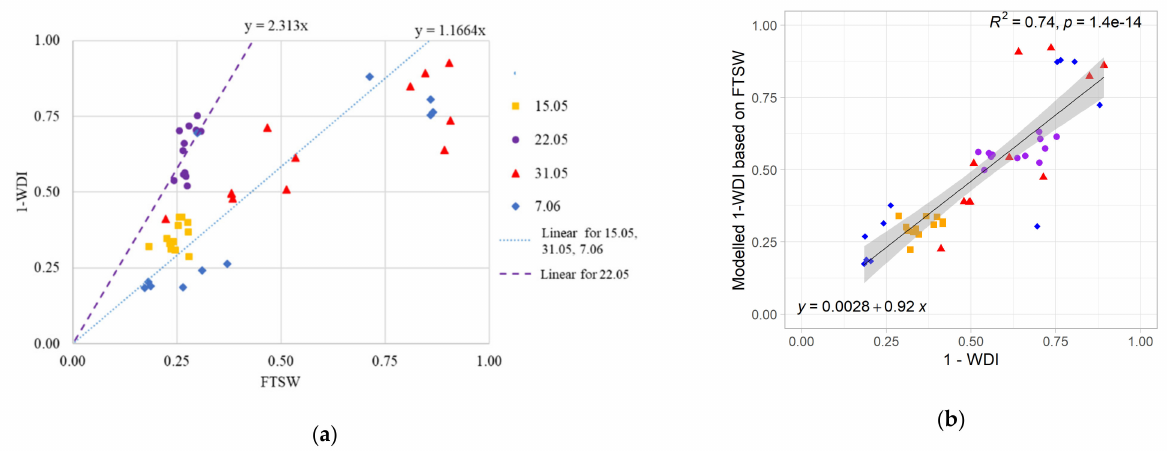
Figure 4. ( a ) Relationship between the Transpirable Soil Water Fraction ( FTSW ) and transpiration rate (1- WDI ; WDI is the Water Deficit Index from images acquired during solar noon) for the winter wheat season in 2018 in Denmark. ET p = 0.49–0.54 mm h − 1 on 15 and 31 May and 7 June and ET p = 0.39 mm h − 1 on 22 May; ( b ) fit between transpiration rate derived from FTSW (Equation (16)) and thermal imagery for the winter wheat season in 2018 in